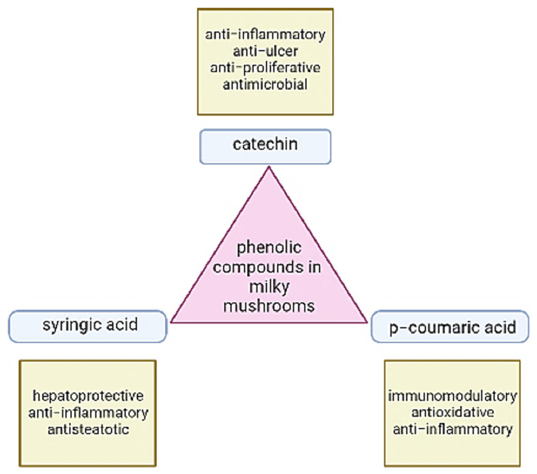
Figure 3. Phenolic compounds in the milky